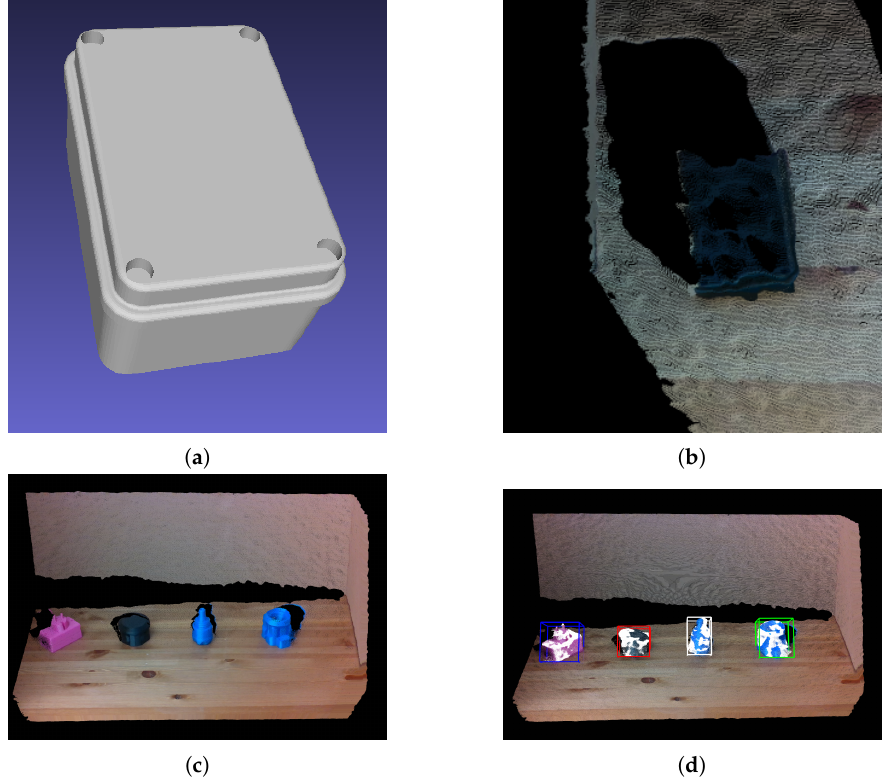
Figure 12. ( a ) CAD model for Object 29, ( b ) an incomplete point cloud representation, ( c ) a scene with 4 objects from the dataset and ( d ) localisation of point clouds as shown by the aligned bounding boxes.